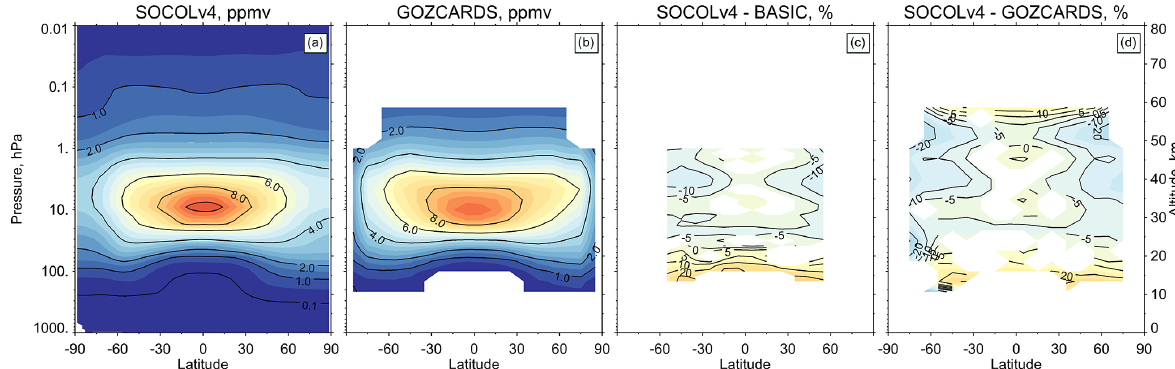
Figure 12. Ozone zonal mean annual mean climatology (1985–2012) calculated by the SOCOLv4 model (ppmv) (a) and provided by the GOZCARDS data (b) . (c, d) Relative difference between the model and the observational composites BASIC and GOZCARDS. White areas are either the missing data or regions where the difference between model and observations is not statistically significant at the 95% confidence